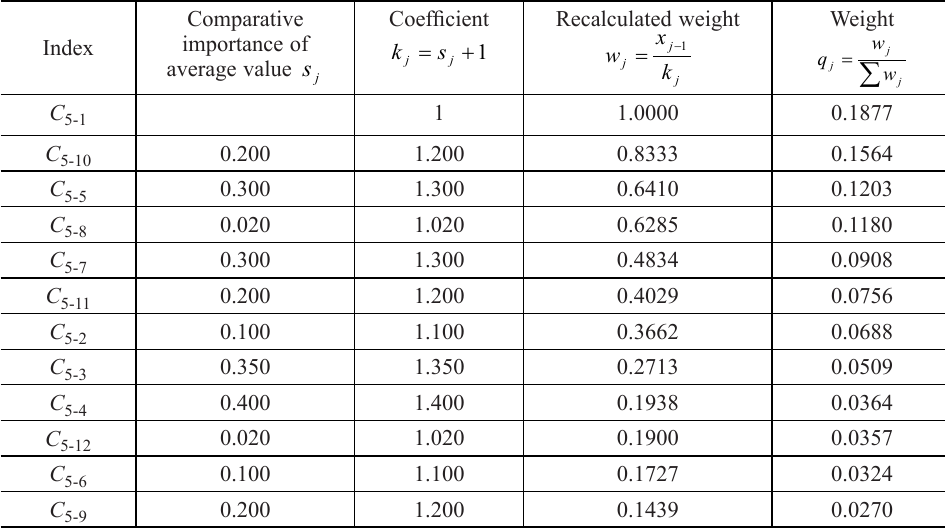
Table 9. Priorities and final weights of sub-indexes reflecting the least unusable